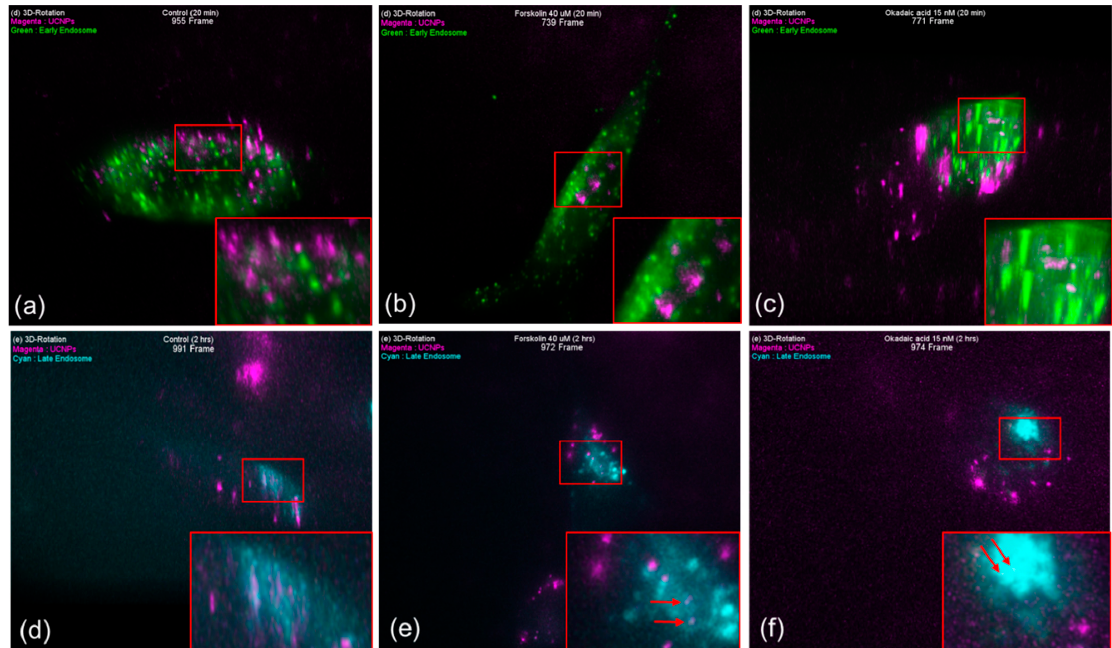
Figure 5. Early state colocalizations of UCNPs with early endosomes or late endosomes in tau aggregated SH-SY5Y cell. ( a ) Control 20 min (955 frame), ( b ) forskolin 20 min (739 frame), ( c ) okadaic acid 20 min (771 frame), ( d ) control 2 h (991 frame), ( e ) forskolin 2 h (972 frame), and ( f ) okadaic acid 2 h (974 frame). Magenta: UCNPs, green: early endosome, cyan: late endosome.